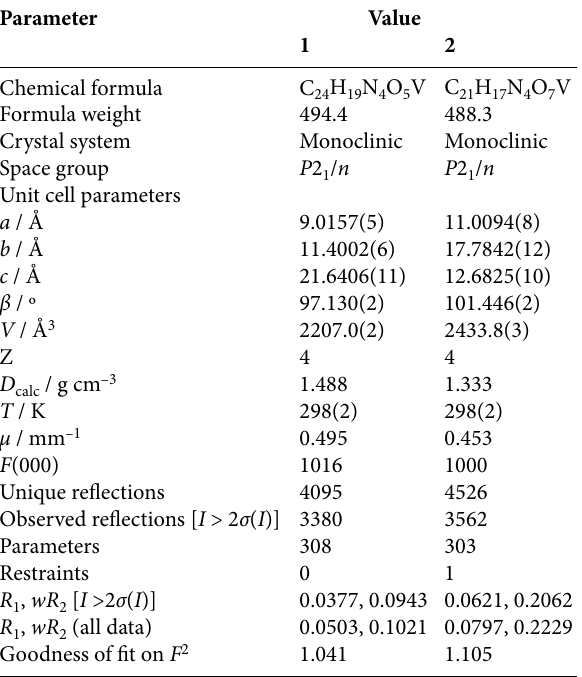
Table 1. Crystallographic data and refinement parameters for the complexes